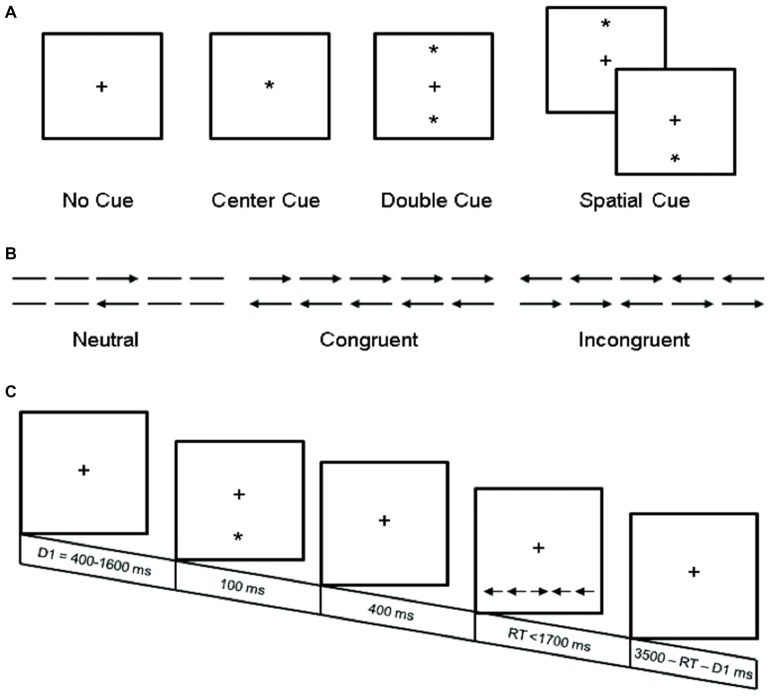
Experimental procedure. (A) The four cue conditions, in which the asterisk cue (*) provides information about the presence (center and double cue) or location (spatial cue) of the upcoming target stimuli; (B) The six target stimuli used in the present experiment; and (C) An example trial (spatial cue—incongruent target stimuli). Adapted from Fan et al. (2002).